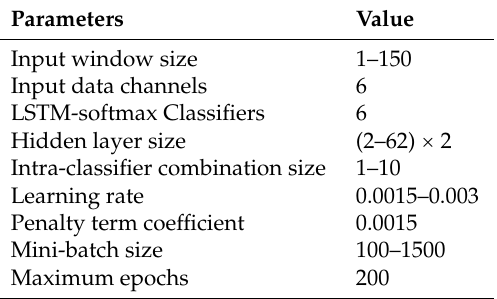
Table 1. Experiment